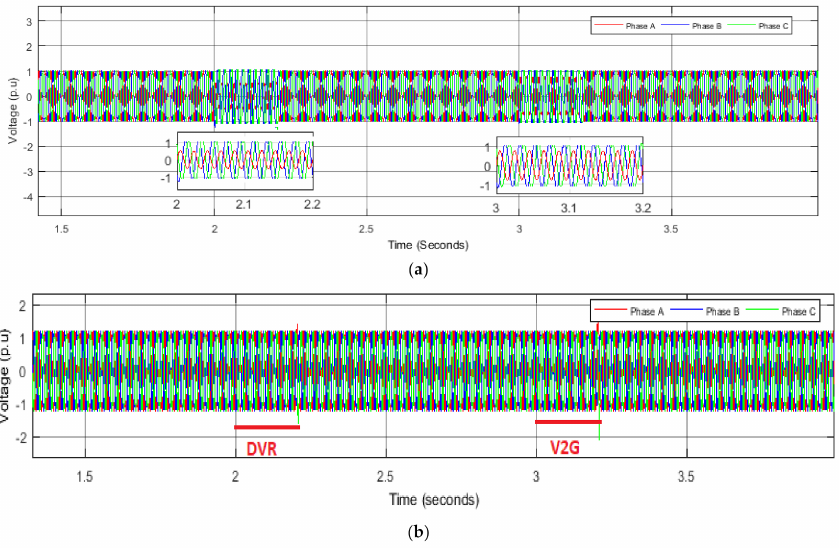
Figure 21. ( a ) Single phase symmetrical fault; ( b ) voltage compensation using DVR and V2G for single phase faults.